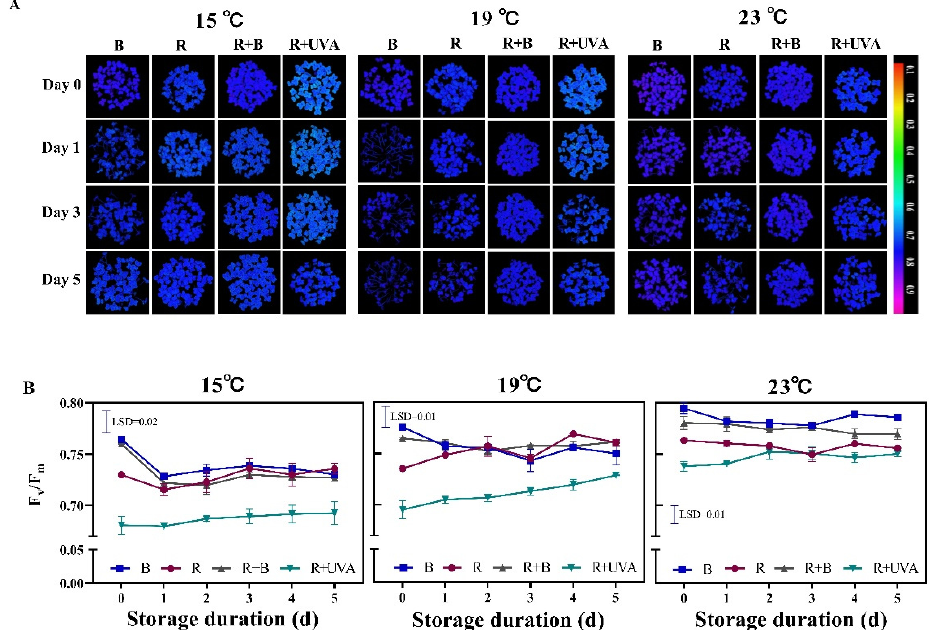
Figure 6. Representative image of the dark-adapted F v /F m distribution ( A ) and extracted F v /F m values ( B ) of intact broccoli sprouts grown for 5 d under different light [blue (B), red (R), mixture of R and B (R+B), as well as mixture of R and UVA (R+UVA)] and air temperature (15, 19, and 23 °C) regimes, and then stored for 5 d under darkness (4 °C and 50% relative air humidity). Error bars indicate SEM (n = 2, each replicate representing the mean of five petri dishes). LSD values ( p < 0.05) are indicated per